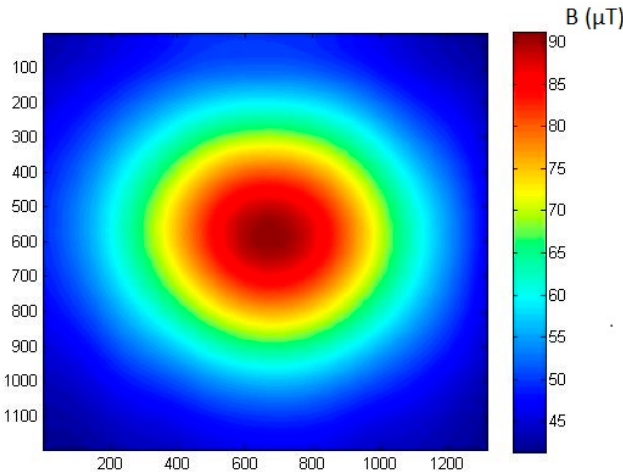
Figure 2. Sample magnetovision measurement of magnetic field induction of ME8 magnetic moment standard. Coordinates of the plot are X and Y (horizontal measurement plane), and vertical component B Z of the magnetic field is shown. The axis of the standard was perpendicular to the measurement plane, and the vertical distance z 0 was set to 140 mm.